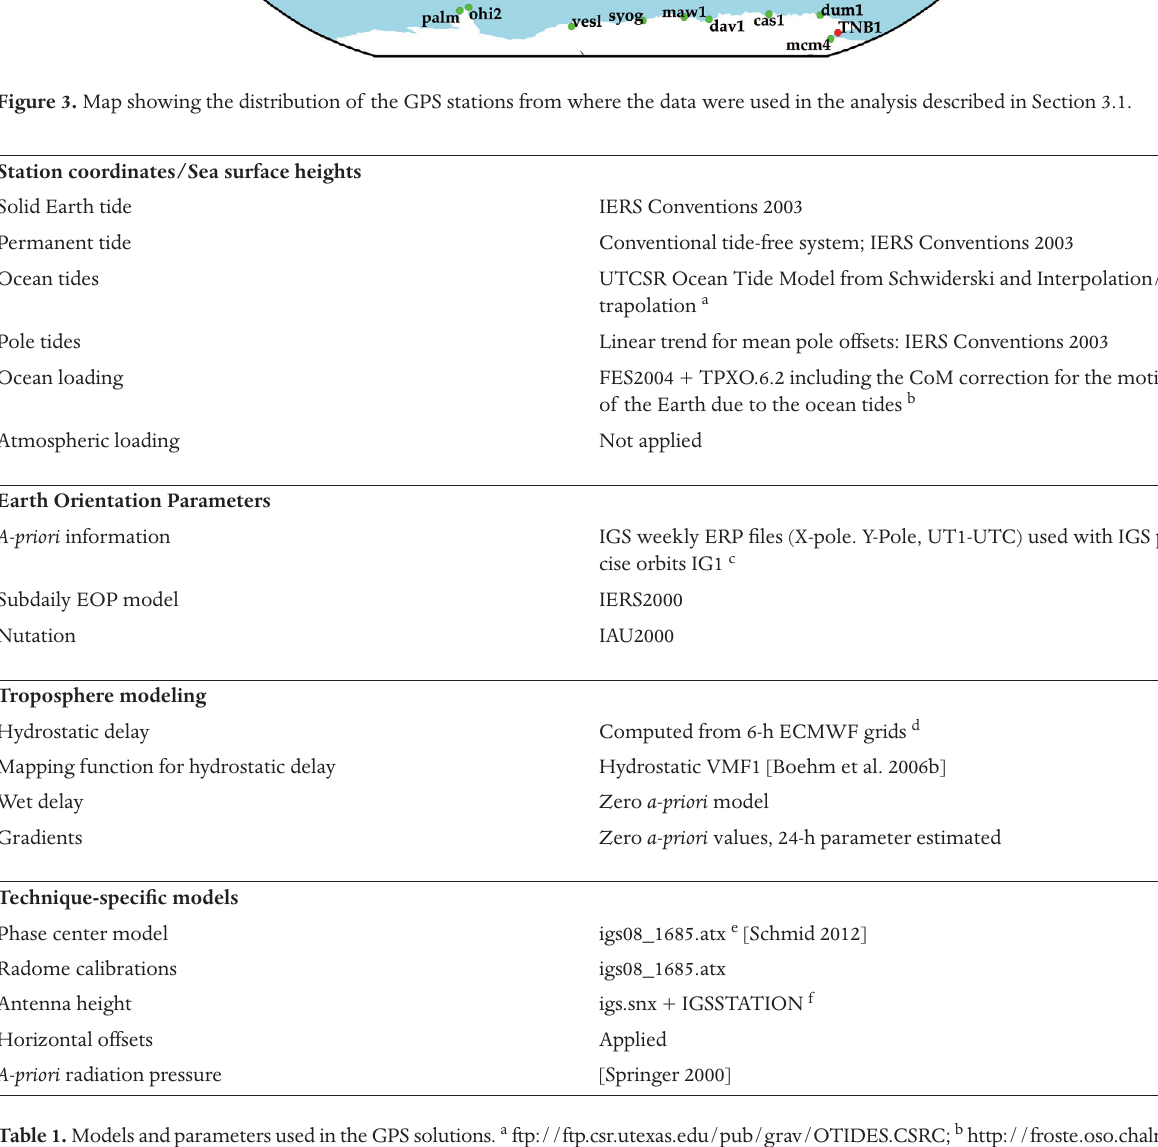
Table 1. Models and parameters used in the GPS solutions. a ftp://ftp.csr.utexas.edu/pub/grav/OTIDES.CSRC; b http://froste.oso.chalmers. se/loading/; c ftp://cddis.gsfc.nasa.gov/gps/products/repro1; d http://ggosatm.hg.tuwien.ac.at/DELAY/; e